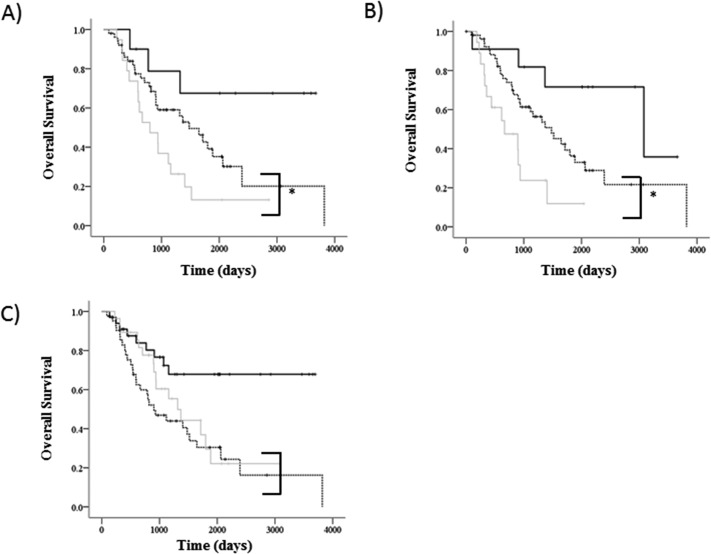
Kaplan–Meier graphs of overall survival.(a) Black line: #10(+)N2(−); dotted: #10(−)N2(+); gray #10(+)N2(+), (p = 0.01*). Parentheses indicates p = 0.04*. (b) Black line: #11(+)N2(−); dotted: #11(−)N2(+); gray #11(+)N2(+), (p < 0.01*). Parentheses indicates p = 0.01*. (c) Black line: #12U(+)N2(−); dotted: #12U(−)N2(+); gray #12U(+)N2(+), (p<0.01*). Parentheses indicates p = 0.38. *
p < 0.05. # indicates “lymph node number” as defined by the Committee of the International Union against Cancer (12). (+) and (−) represent the positive and negative status of the node, respectively.